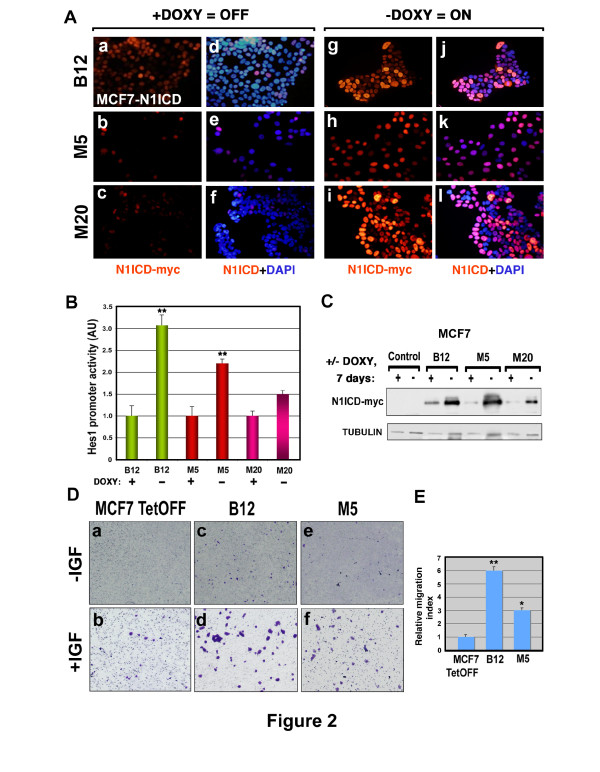
Inducible N1ICD overexpression in MCF-7 cells promotes a migratory behavior. (Aa-f) General view of the MCF-7 Tet-Off clones (B12, M5 and M20) cultured in the presence of DOXY. a-c, anti-myc staining reveals leaky myc-N1ICD expression; d-f, anti-myc and DAPI staining overlapping. (Ag-l) General view of these clones cultured in the absence of DOXY. g-i, anti-myc staining reveals N1ICD induction in these cells; j-l, anti-myc and DAPI staining. (B) Quantification of Hes1 promoter activity in MCF-7 uninduced and induced clones. Data are mean ± SEM of quadruplicates in three independent experiments (**P <0.005 determined by Student's t-test). (C) Western blot analysis of myc-N1ICD expression in MCF-7 control cells and MCF-7 clones after seven days of culture with or without DOXY. (D) Representative images of transmigrated cells in basal (-IGFI) and IGF-I supplemented (+IGF) cells. (a, b) control, (c, d) N1ICD-induced B12 and (e, f) M5 MCF-7 cells. (E) The relative migration index for each cell type is represented. Data are mean ± SEM of duplicates in three independent experiments (*P <0.05, **P <0.005 determined by Student's t test). DAPI, 4,6-Diamidino-2-phenylindol; DOXY, doxycycline; MCF-7, Michigan Cancer Foundation-7 breast cancer cell line; N1ICD, Notch one intracellular domain